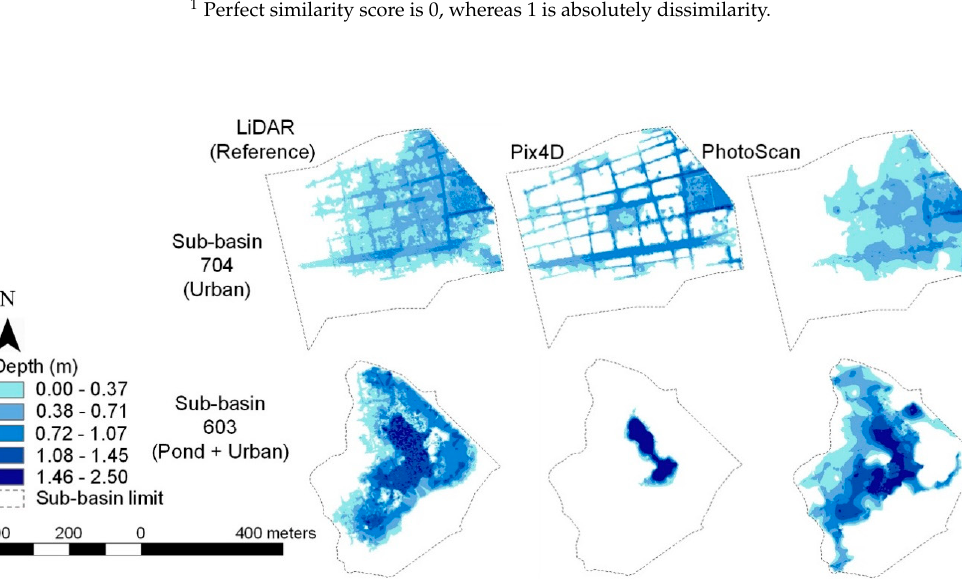
Figure 8. Flood extent to the corresponding DEM in 704 and 603 sub-basins.